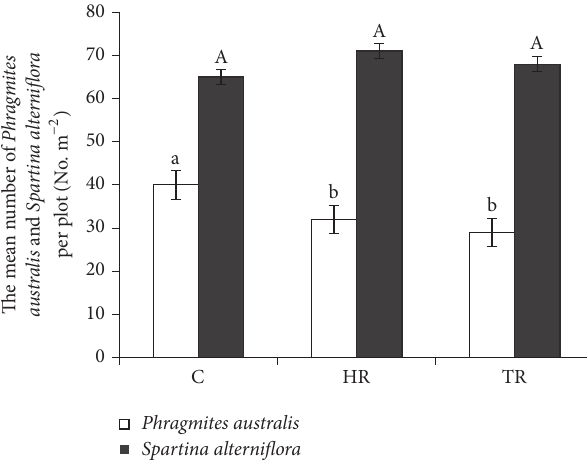
Figure 4: The number of Phragmites australis and Spartina alterni- flora individuals per plot (mean ± SE) in different mowing treat- ments: control (C), HR (half-removal), and TR (total-removal). Different letters indicate a significant difference ( 𝑃 < 0.05 ) among